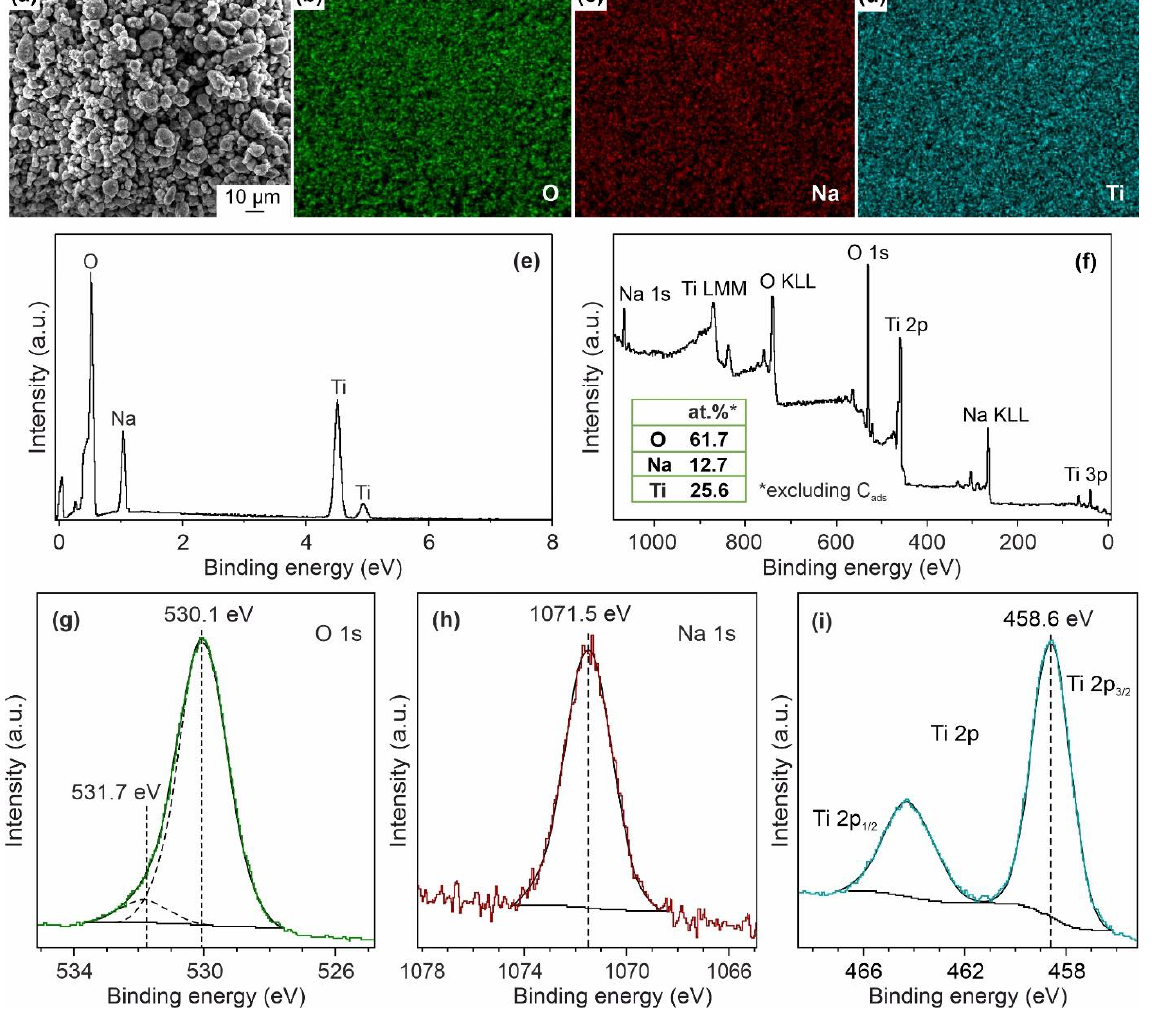
Figure 3. SEM-image of the analyzed area ( a ), corresponding elemental maps ( b – d ), and EDX- spectrum ( e ) for NTO-120 sample. XPS-spectra for the NTO-350 surface: survey scan ( f ), O 1s ( g ), Na 1s ( h ), Ti 2p ( i ). The inset in ( f ) shows the content of elements estimated from XPS peak areas.